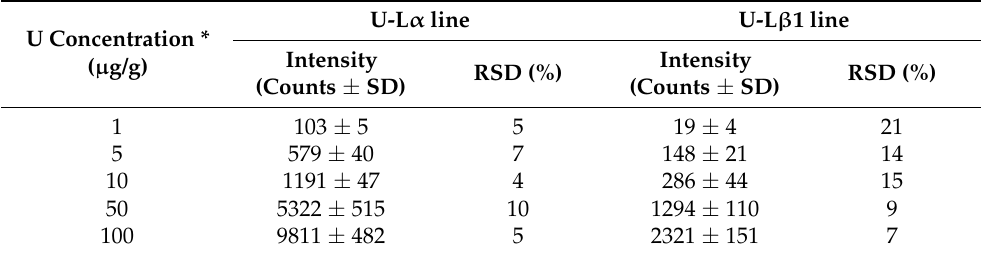
Table 1. X-ray intensity of U-L α and U-L β 1 lines in 1 µ L of U standard in 0.1 M HNO 3